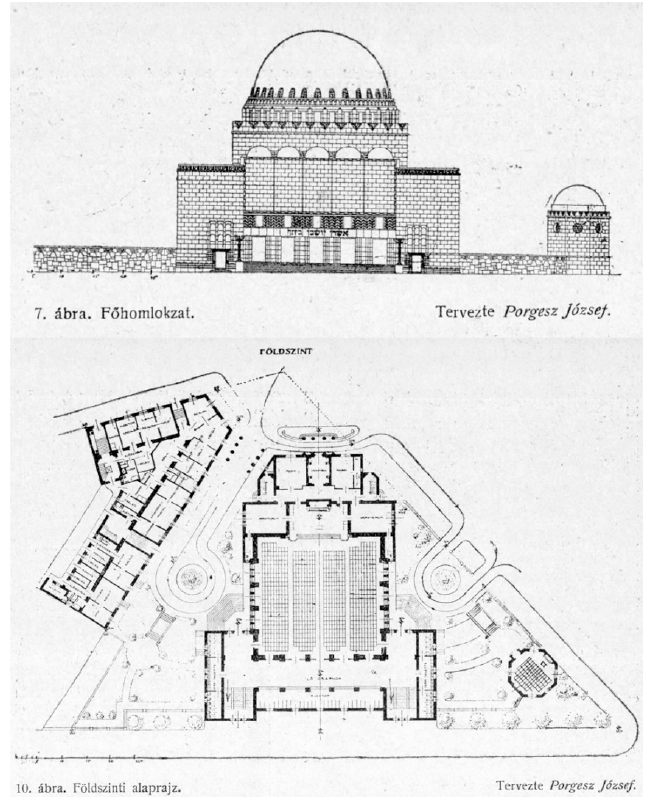
Figure 5. Main façade and plan of the ground floor of the Buda synagogue from the design of József Porgesz submitted to the 1913 architectural competition. Source: Épit ő Ipar , 27 July 1913, p. 328.